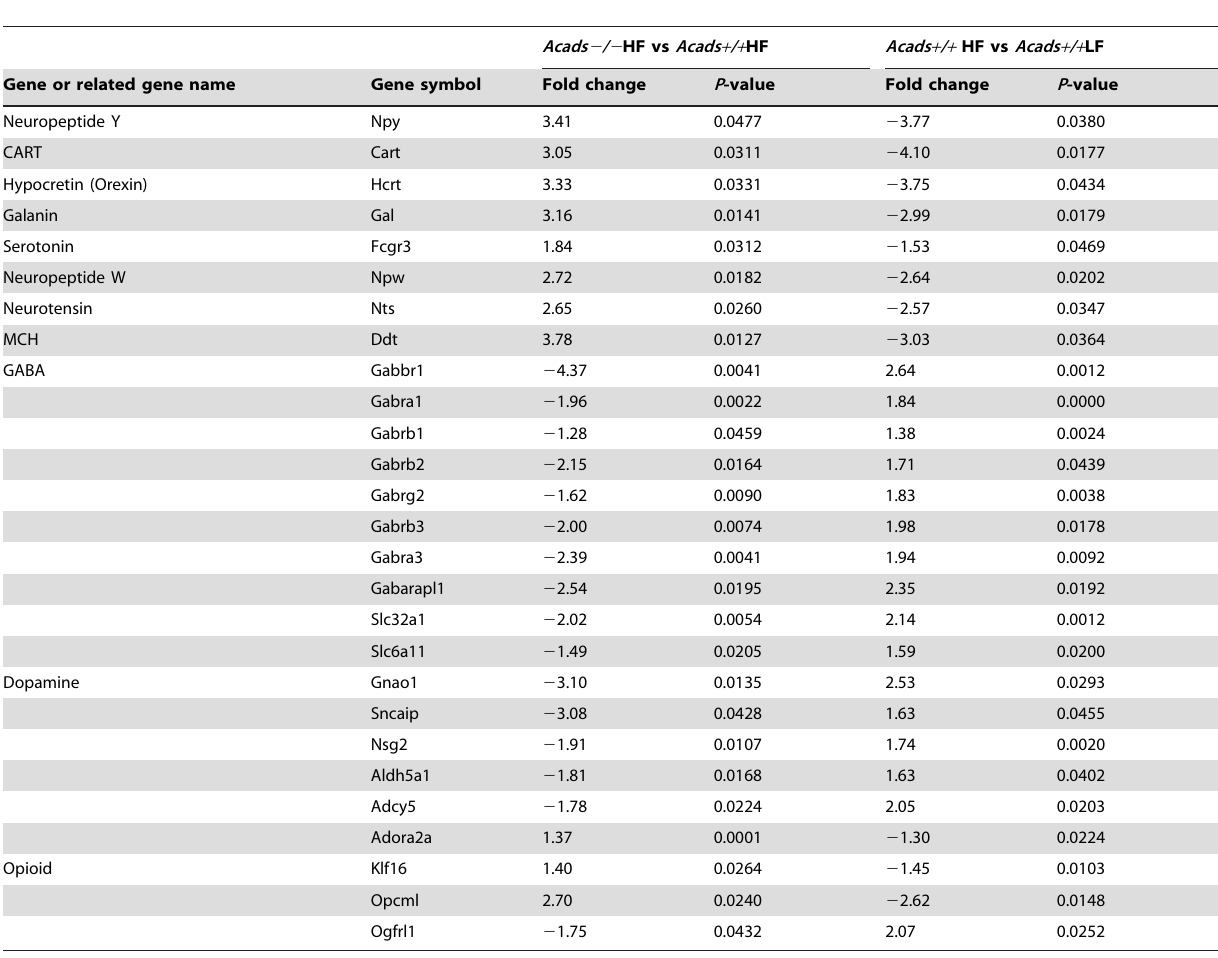
Table 3. Differentially expressed neuropeptide and neurotransmitter genes in microarray of brain.